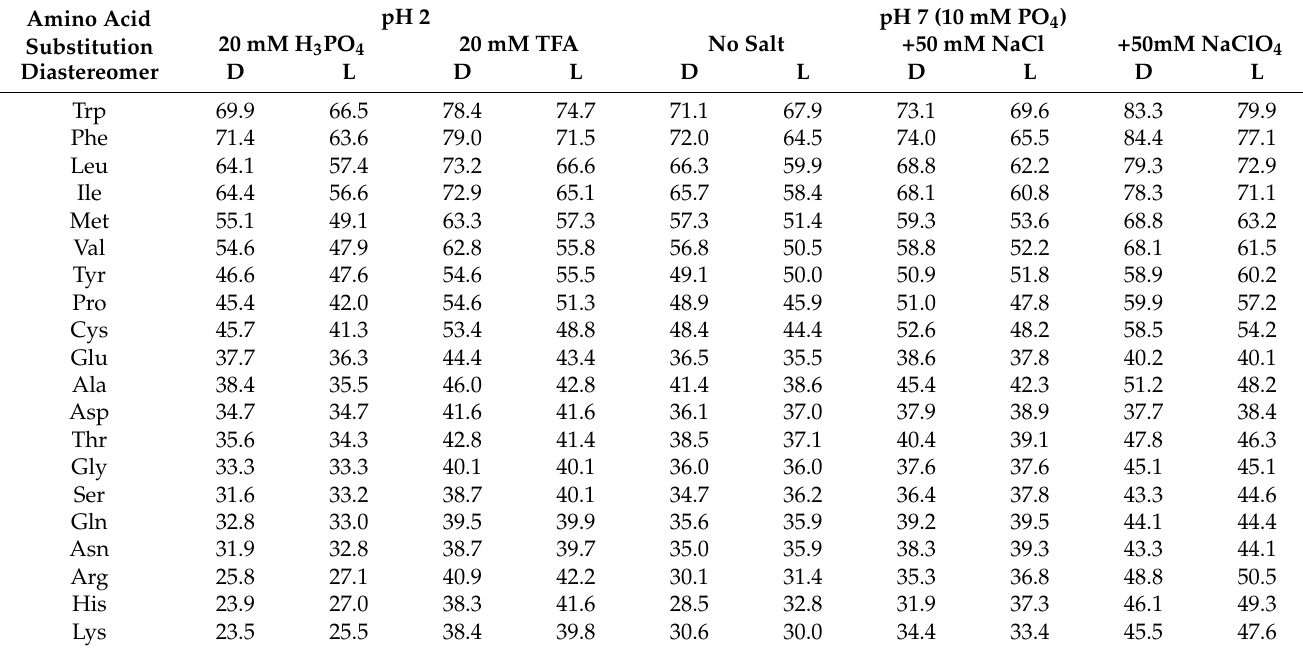
Table 10. Retention times in mobile phases (presence of nearest neighbour effect)